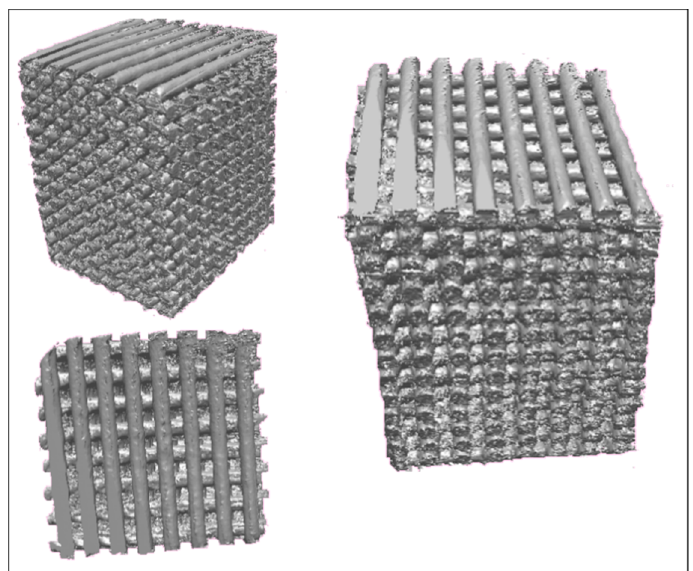
Figure 3. 3D reconstructions obtained from micro-CT analysis on PCL scaffolds with a 0/90° lay down pattern.